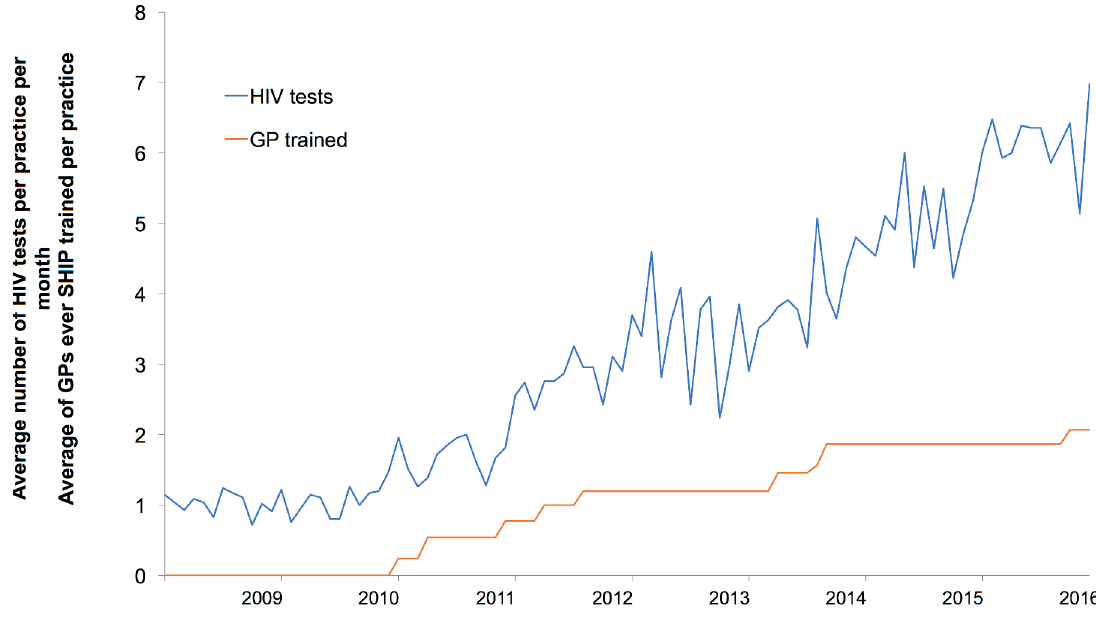
Fig 2. Average number of HIV tests and GPs trained per practice.